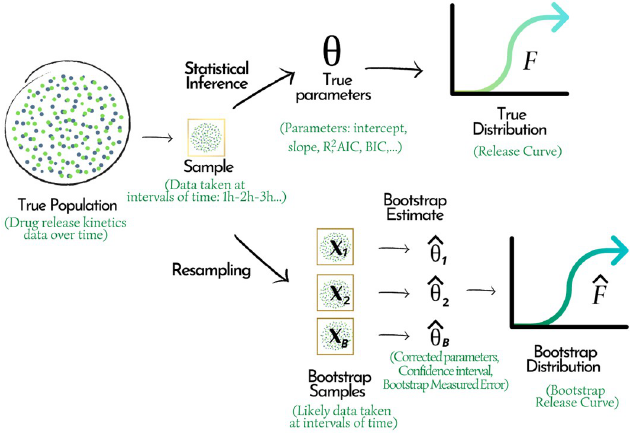
Fig 3. Diagram of the process for parameter estimation by Bootstrap